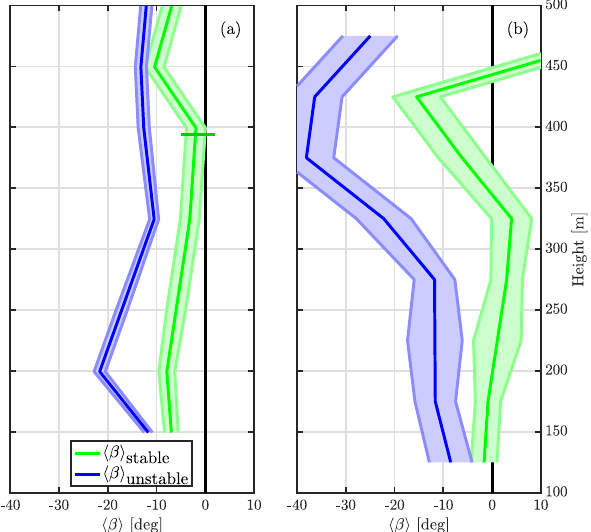
Figure 7. Vertical profiles of (cid:104) β (cid:105) for FINO3 ( a ) and Hamburg ( b ) under unstable (blue) and stable (green) conditions. The horizontal green line marks the PBL height under stable conditions based on